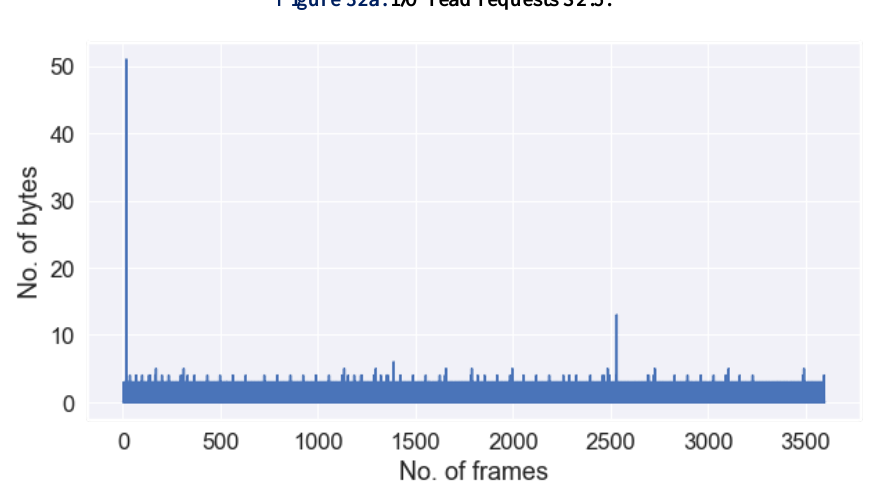
Figure 32a. I/O read requests S2.5.